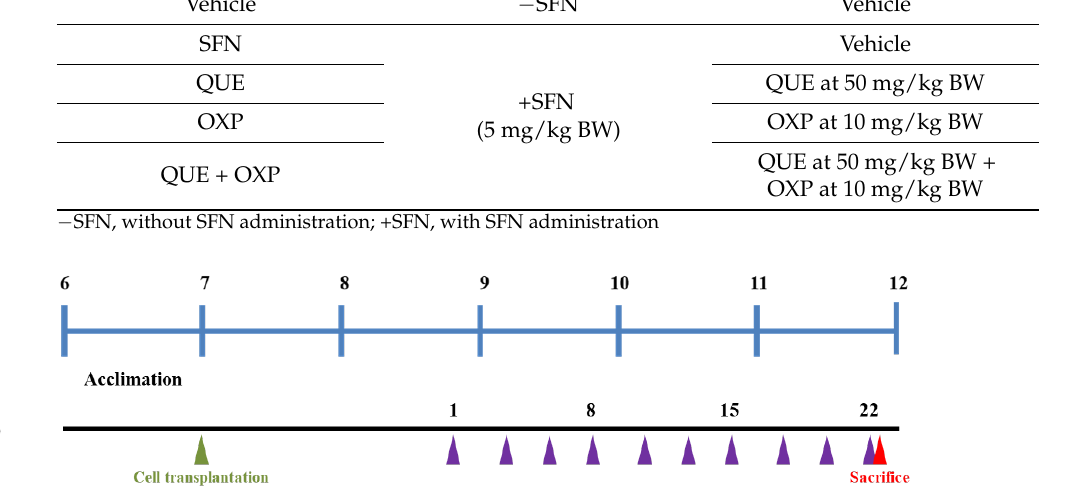
Table 1. Experimental groups for HCT116 cancer cell xenograft in BALB/c nude mice. Group